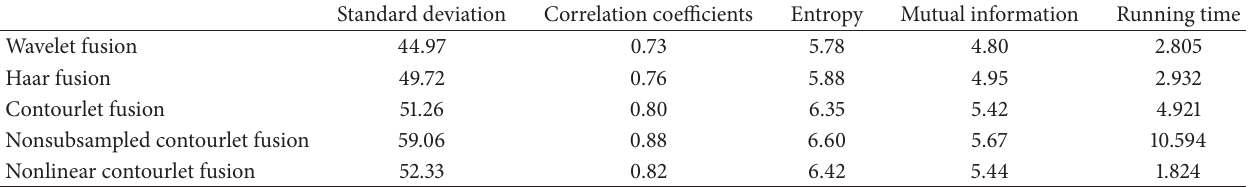
Table 6: Index of performance